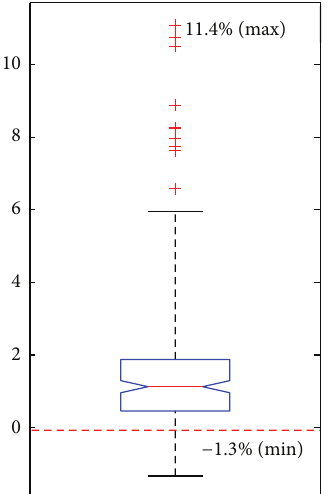
Figure 4: Relationship between crack-calcification distance and fatigue life